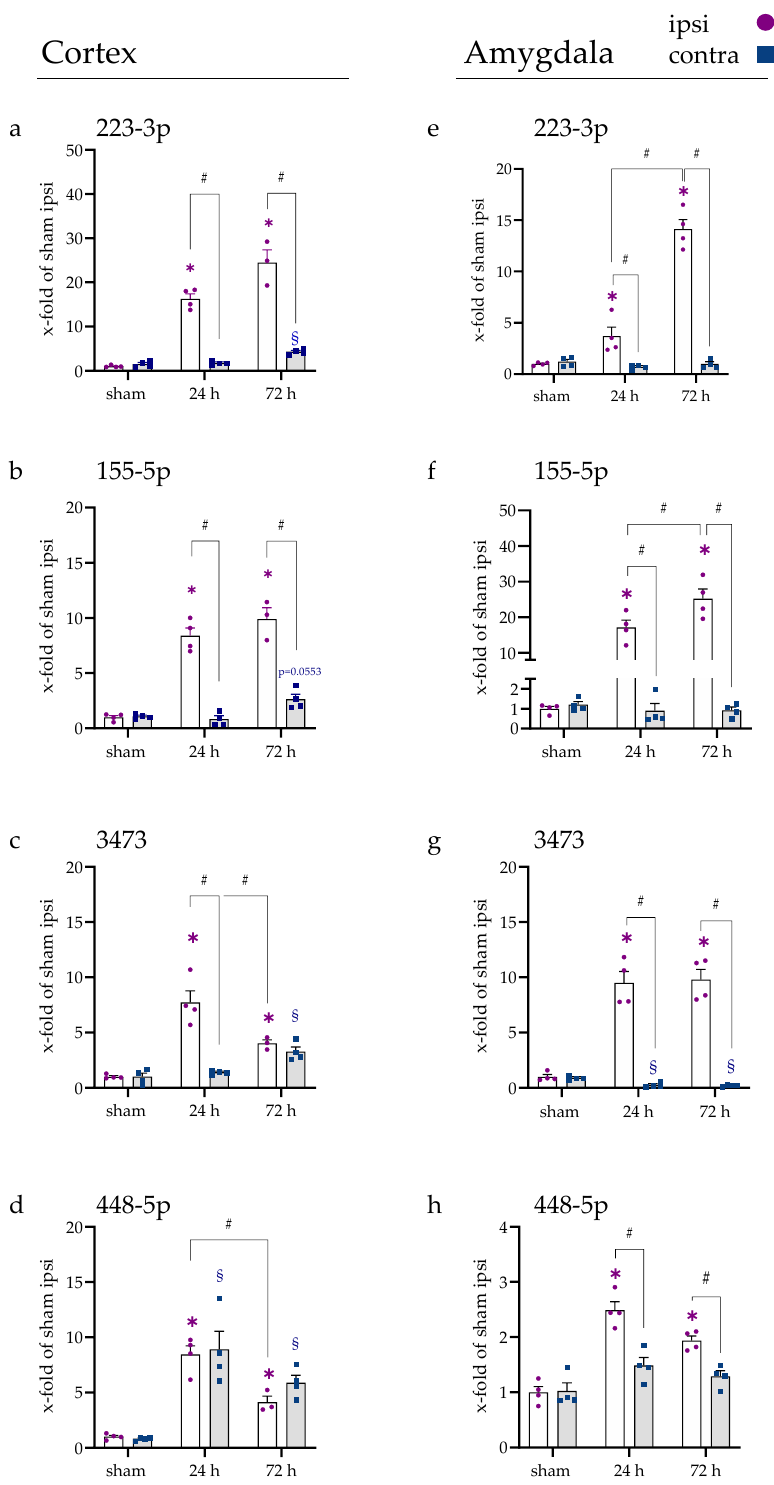
Figure 2. miRNA expression in cerebral cortex and amygdala after 24 h and 72 h following tMCAo. ( a , e ) miRNA levels of miR-223-3p in the cerebral cortex and amygdala, ( b , f ) miR-155-5p, ( c , g ) miR- 3473, and ( d , h ) miR-448-5p. The graphs show the individual values for ipsi (purple) and contra (blue) and the mean in bars. Data are compared to the sham ipsi group and pictured with the x-fold expression of this group ± SEM. (*) shows a significant difference between the ipsilateral side and sham ipsi where (§) shows a significant difference between the contralateral side and sham contra. (#) comparison as